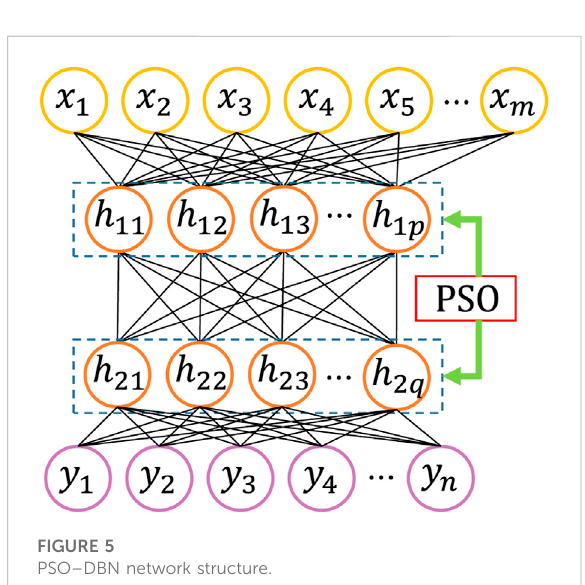
FIGURE 4 DBN structure. FIGURE 5